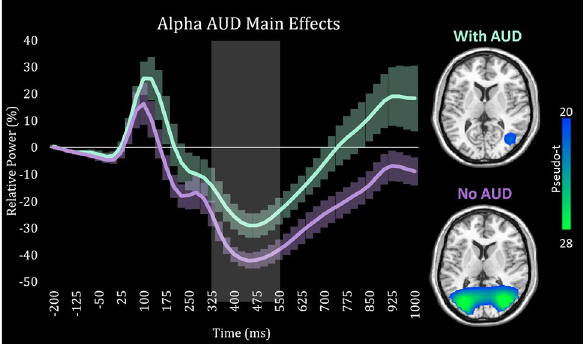
Figure 2. Voxel time series of alpha activity during visual-spatial processing. Grand averaged alpha source images revealed peak voxels in bilateral visual cortices. Time series were then extracted from these voxels in each participant, averaged across hemisphere, and were plotted with time (ms) on the x-axis and relative amplitude (%) on the y-axis. For display purposes, the time series has been averaged across those with AUD (teal) and those without AUD (purple). The area highlighted in gray (300 to 550 ms) reflects the time period that was used for the source analysis. Factorial ANCOVA showed a main effect of AUD, such that individuals diagnosed with AUD (teal) exhibited a significantly weaker alpha response compared to those without AUD (purple). Error bars indicate ± 1 standard error of the mean. To the right, source images of the alpha response have been split according to AUD diagnosis with the color scale legend shown on the right. These images clearly show the same effect observed in the time series data. Note that these images are shown for display purposes only and statistical comparisons were made using the average over the highlighted active window from the extracted time series in an ANCOVA model.